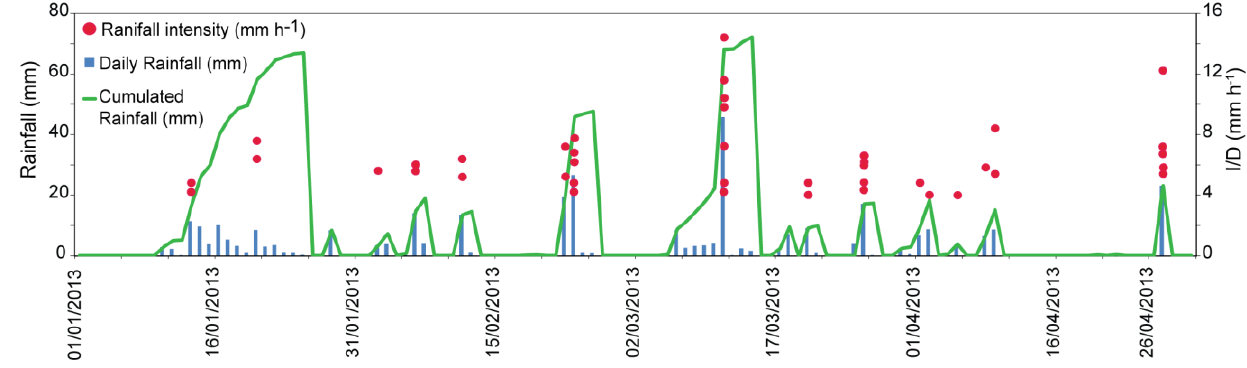
Figure 8. Rainfall measurements from the Todi rain gauge from 1 January to 30 April 2013. The purple dots represent the rainfall intensity in mm∙h −1 , the blue bars represent the daily rainfall, and the green line represents the cumulative rainfall. Only events that exceed 4 mm∙h −1 are shown.